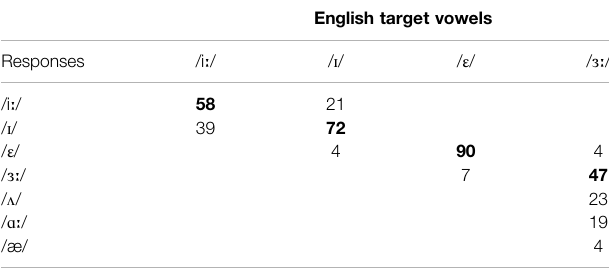
TABLE 3 | Identi fi cation of the four English target vowels by 43 Spanish/Catalan learners of English. Mean correct identi fi cation percentages are highlighted in bold, misidenti fi cations equal to or lower than 3% have been omitted.